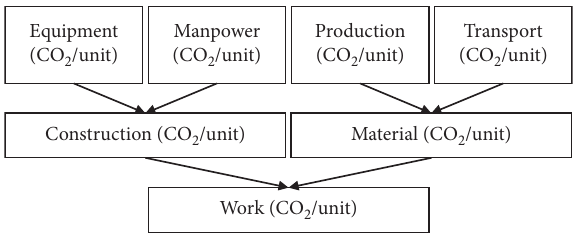
Figure 2: Carbon dioxide unit calculation structure